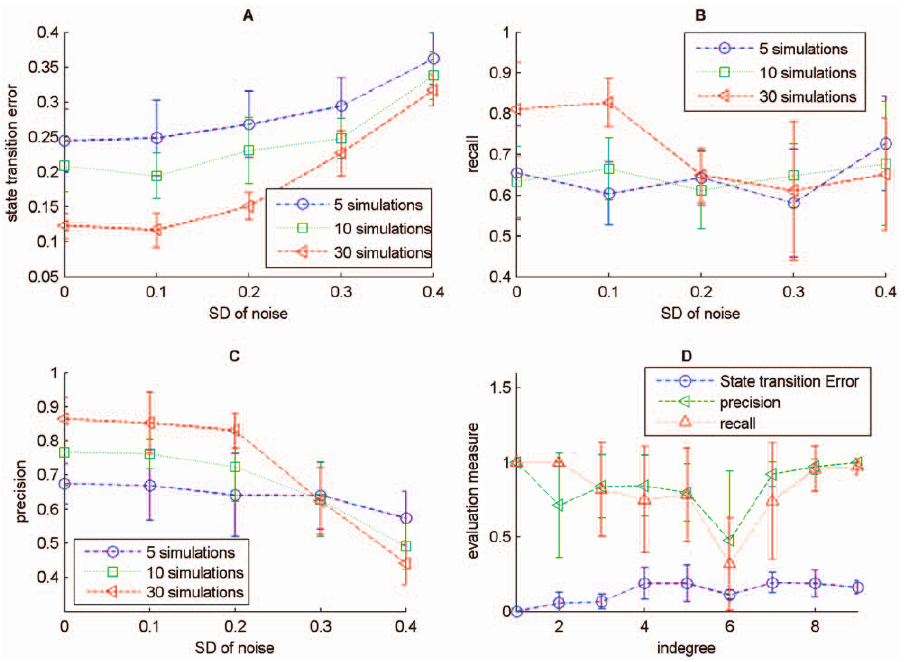
Figure 6. Evaluation of the network with varying indegrees using ReBMM. Figure A is the noise level vs. state transition error, Figure B is a plot of noise level vs. recall and Figure C indicates the noise level vs. precision. Noise level is the standard deviation s of Gaussian distribution with zero mean. In Figure D different evaluation measures are plotted for different indegrees for 30 simulations and noise level 0.1.